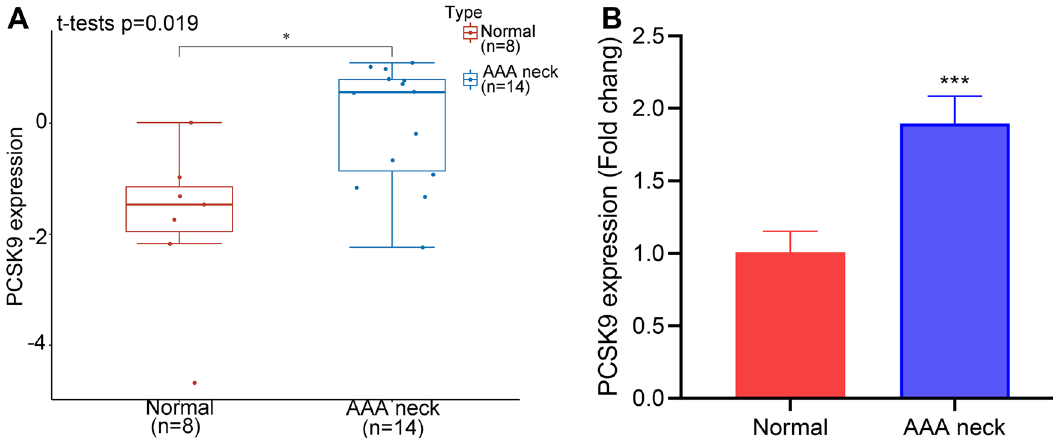
Figure 2. The expression of PCSK9 in AAA neck and normal tissues. ( A ) The expression of PCSK9 in human AAA neck (n = 14) and normal tissues (n = 8) in GSE47472 dataset from GEO database. Student t-test was used to compare the different expressions. * p < 0.05. ( B ) The RT-qPCR results showed the PCSK9 mRNA expression in AAA neck of AAA mice model (n = 5) and normal tissues (n = 5). Student t-test was used to compare the mRNA expressions of PCSK9. *** p < 0.001.